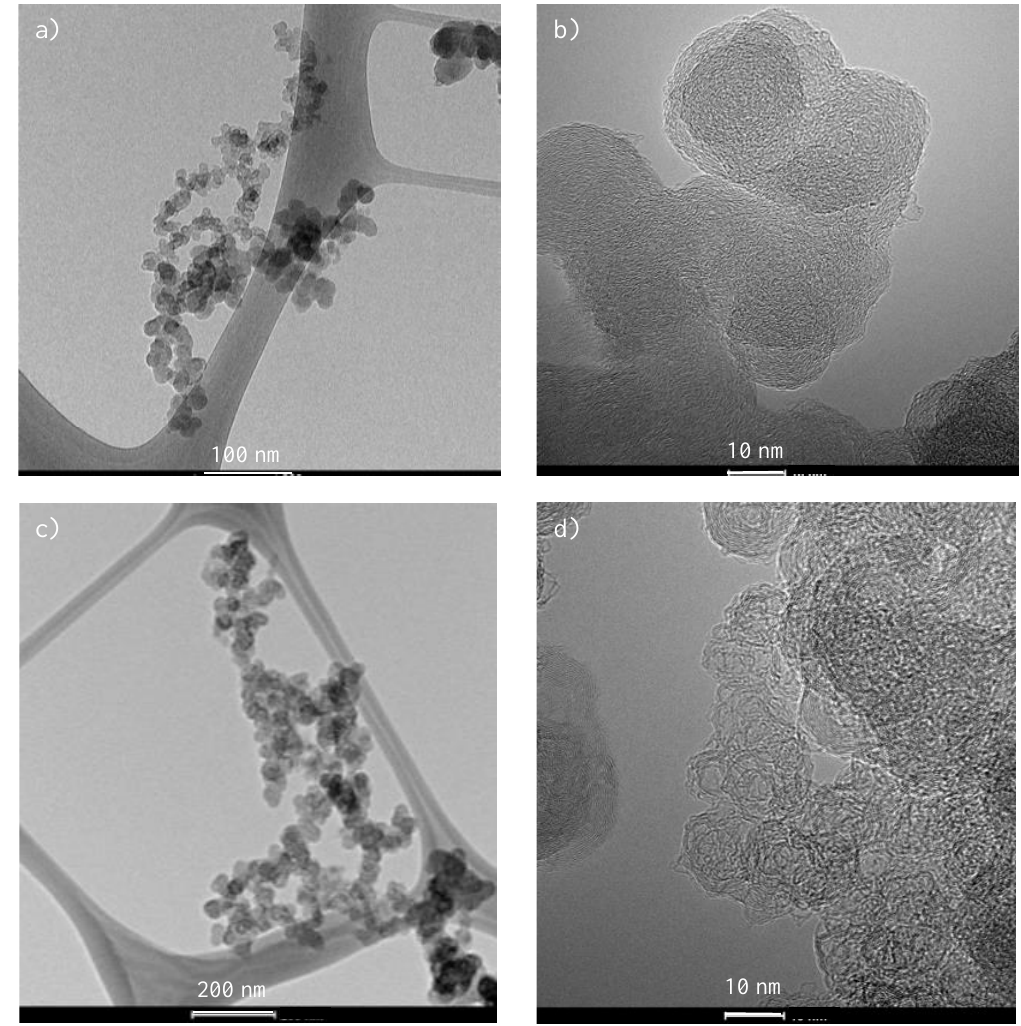
Figure 6. HRTEM images of the carbon black XC-72. Nascent form: illustrative aggregate ( a ); higher magnification image showing amorphous nanostructure of individual particles ( b ); Microwave heated: illustrative aggregate, unaltered in general morphology ( c ); and higher magnification image showing restructured lamellae within individual particles ( d ).